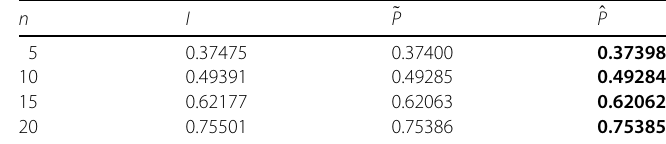
Table 4 ρ ( G –1 F ), ρ ( (cid:9) G –1 (cid:9) F ), and ρ ( ˆ G –1 ˆ F ) with α = 0.2 and ω i = 0.7 for Example 2 n I ˜ P ˆ